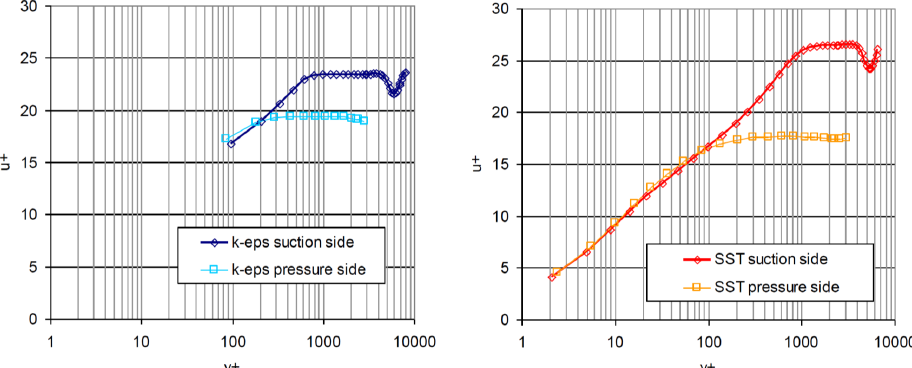
Figure 9. Boundary layer estimation on the pressure and suction sides of the guide vane with different y + values and turbulence models [6]. u + is the dimensionless velocity: the velocity u parallel to the wall as a function of y (distance from the wall).